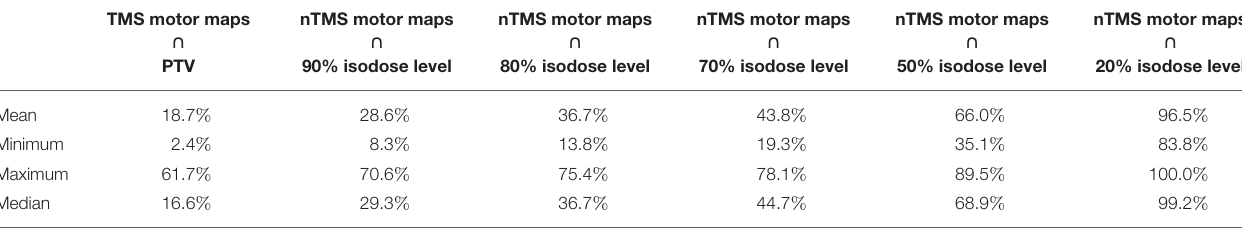
TABLE 2 | Spatial relation of motor maps to isodose levels.